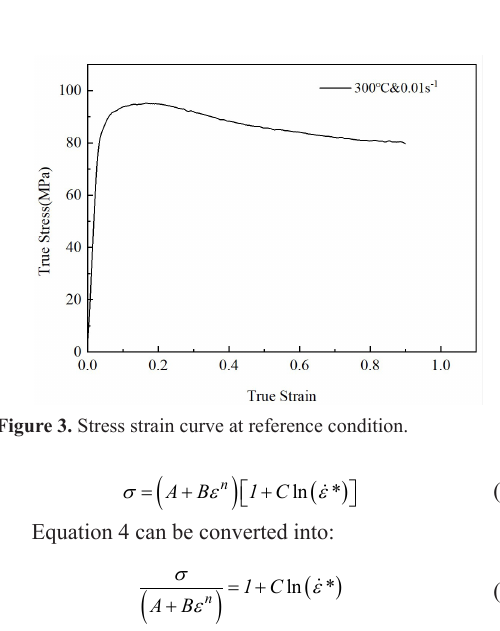
Al-matrix composite 2